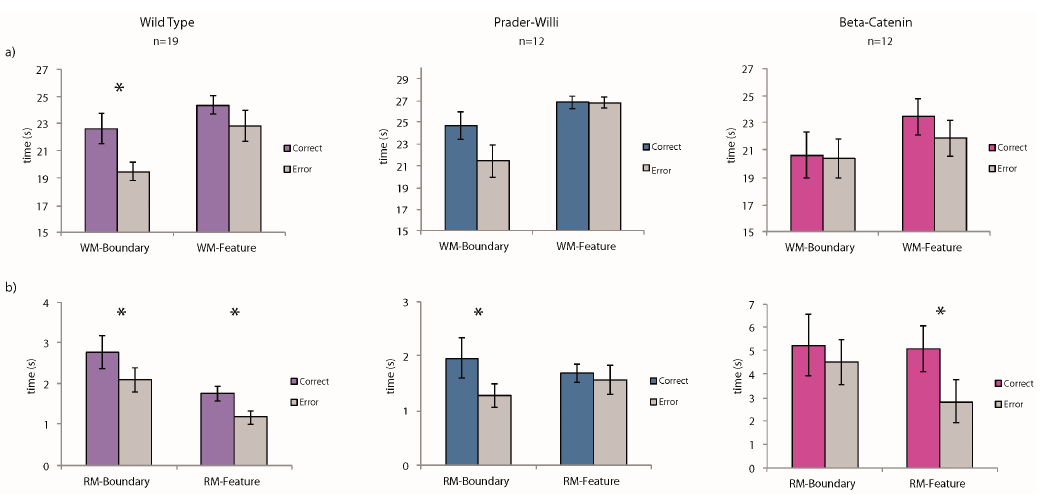
Figure 2. ( a ) Of the three groups, only the wild-type (WT) mice successfully used the boundary geometry to guide their navigation in the working-memory task (WM). Although the Prader-Willi (PW) group shows a clear trend in this direction, their preference for the geometrically correct corners was not significant. None of the groups showed a significant use of the striped landmark feature to guide their working-memory spatial behavior; ( b ) In the reference-memory task (RM) with one stable target location, the WT group relied on both the boundary geometry and landmark feature to find their goal. Consistent with their behavioral trend in the working-memory condition, PW mice successfully learned to use environmental geometry by the latter half of the 20 learning trials. However, this improvement did not apply to the feature condition. The Beta-catenin (BC) mice showed the opposite pattern from PW mice: BC mice learned to use the feature cue to guide navigation but continued to fail in the boundary condition. Asterisk denotes significant difference between correct choice and error ( p < 0.05).